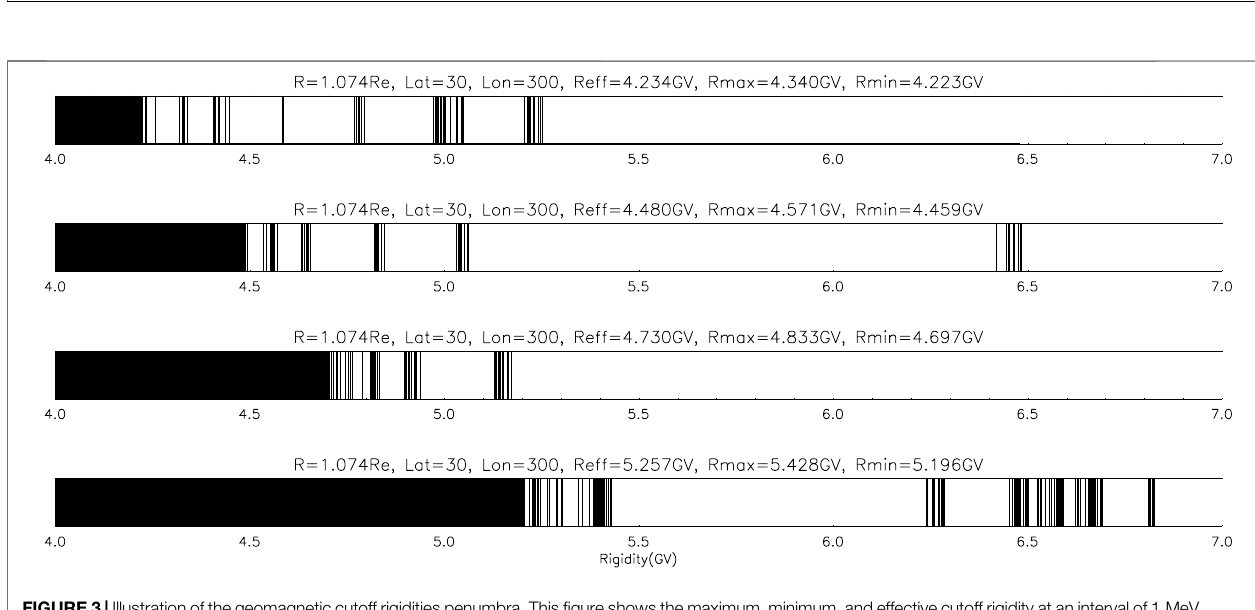
The position with the strongest relative decrease is in the magnetic equatorial regions of North and South America and the outer boundary of the SAA region, in which the outer boundary of the SAA region decreases most strongly, with a relative change of about 15%. Figure 2 is the pole positions of the IGRF magnetic fi eld for different years from 1900 to 2025 with the time resolution of 5 years. The blue dots are the magnetic dip poles, and the red ones